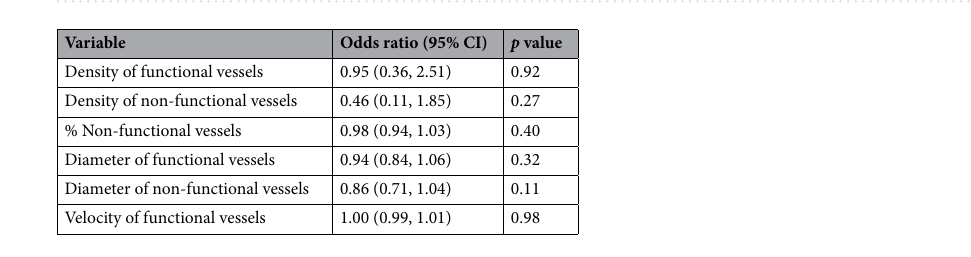
Table 3. Univariate analysis of tumor vessel characteristics with RECIST response among patients who had received neoadjuvant therapy (n = 19).